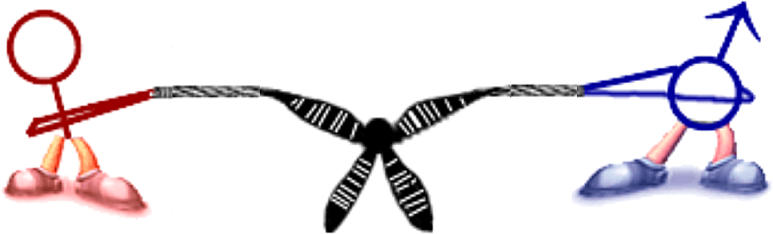
Sexually antagonistic genes create a tug-of-war over the genome. (Image: Adam Chippindale and Helene Van)